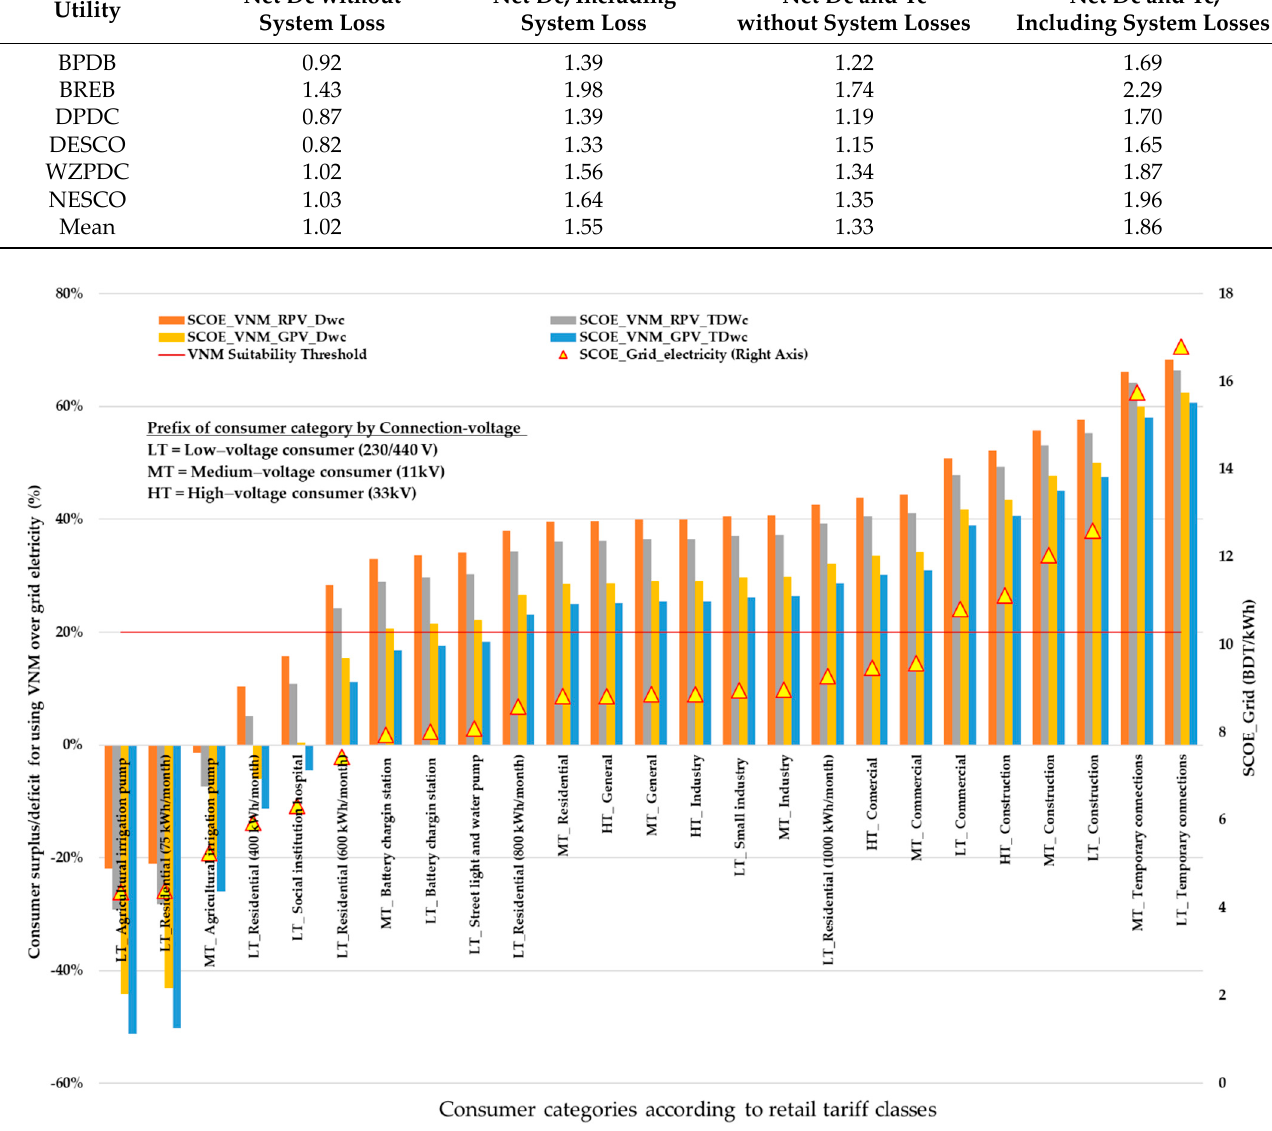
Figure 6. Consumer surplus/deficit for using VNM over grid electricity for 25 consumer categories in Bangladesh. Positive values on the left vertical axis indicate consumer surplus, and negative values indicate deficit. The right vertical axis shows the socket cost of grid electricity for each consumer category.